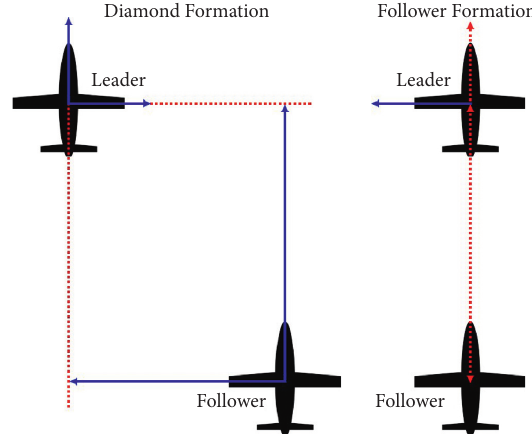
Figure 1: Typical configurations of UAV formation.